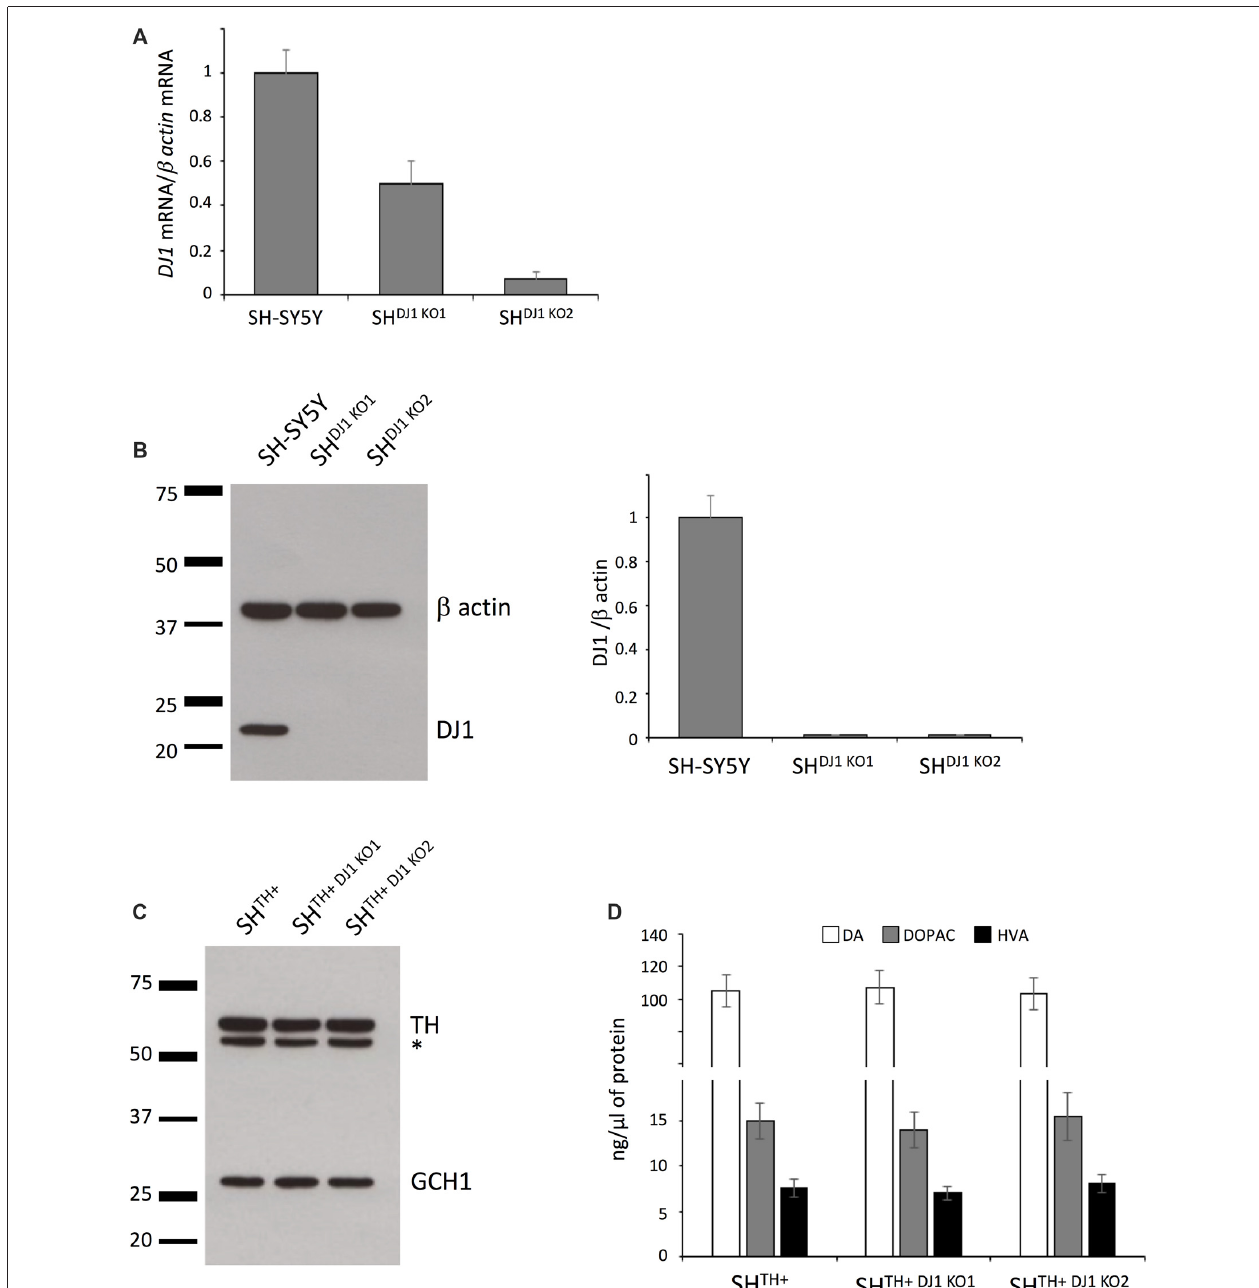
FIGURE 3 | Knocking out DJ-1 has no influence on DA turnover. (A) DJ-1 mRNA expression analysis in the wildtype (SH-SY5Y) and DJ-1 knockout SH-SY5Y cells (SH DJ - 1 KO1 and SH DJ - 1 KO2 ). (B) Western blot analysis of DJ-1 in SH-SY5Y, SH DJ - 1 KO1 and SH DJ - 1 KO2 showed complete loss of DJ-1 in both DJ-1 knockout lines. β -actin served as a loading control. (C) Immunoblotting using antibodies against TH and GCH1 in SH TH + , SH TH + DJ - 1 KO1 and SH TH + DJ - 1 KO2 cells. (D) HPLC analysis showed no differences in levels of DA, DOPAC and HVA between wildtype and DJ-1 knockout lines. TH, tyrosine hydroxylase; DA, dopamine; DOPAC, 3,4-dihydroxyphenylacetic acid; HVA, Homovanillic acid; ∗ non-specific band.